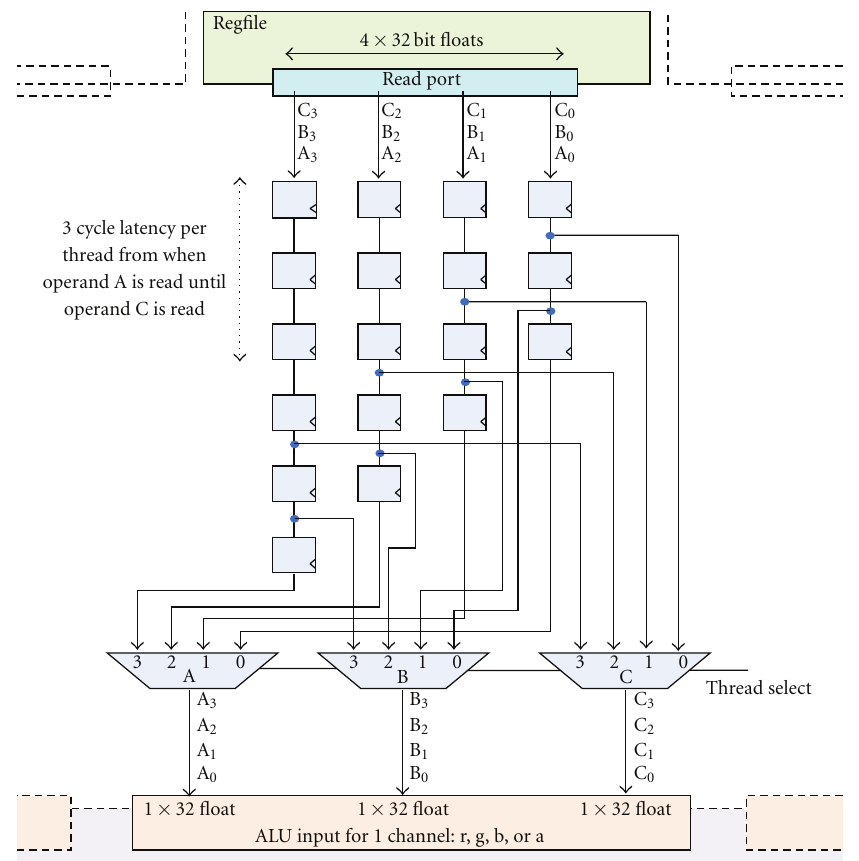
Figure 8: A circuit for transposing the thread-interleaved operands read from the central register file into a correctly ordered sequence of operands for the ALU